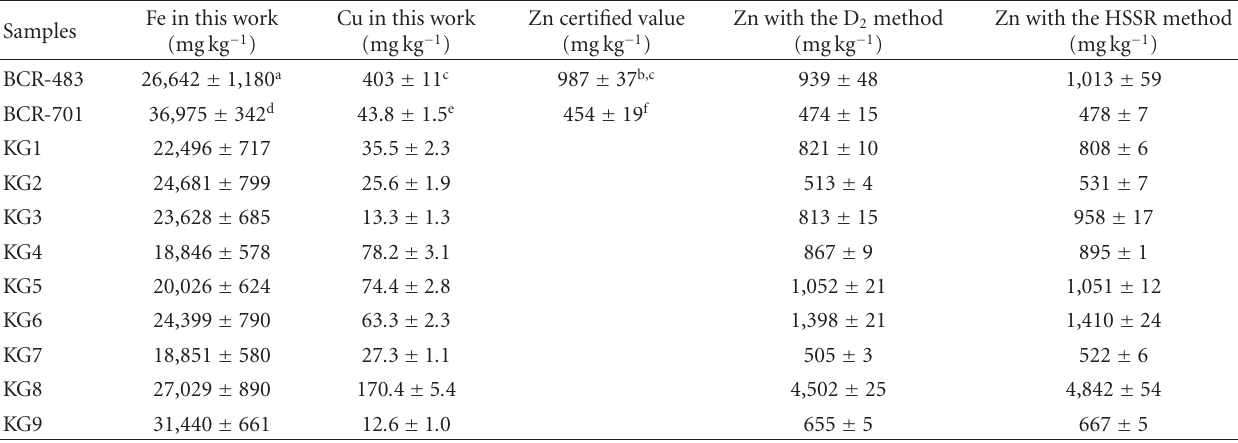
Table 3: Pseudototal Fe, Cu, and Zn concentrations (mean value ± standard deviation) measured in certified reference soil ( n = 3) and kitchen garden (KG) soil samples ( n = 3).